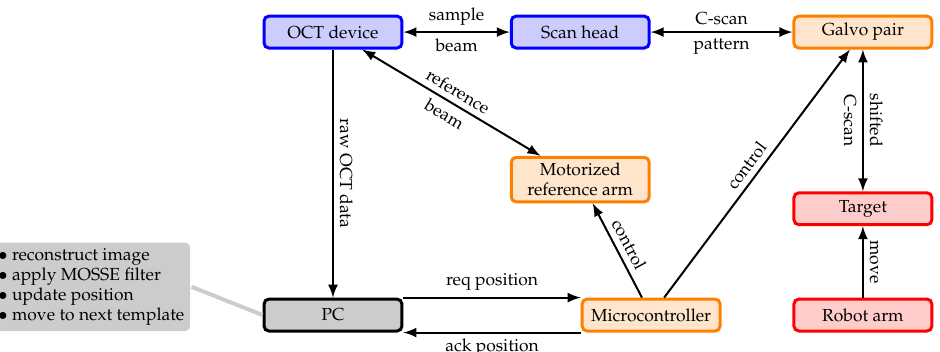
Figure 1. Components of the proposed tracking system. It includes an OCT imaging system (blue), additional hardware to reposition the field-of-view (FOV; orange), a computing device running the tracking loop (gray), and a target moved by a robot arm for evaluation